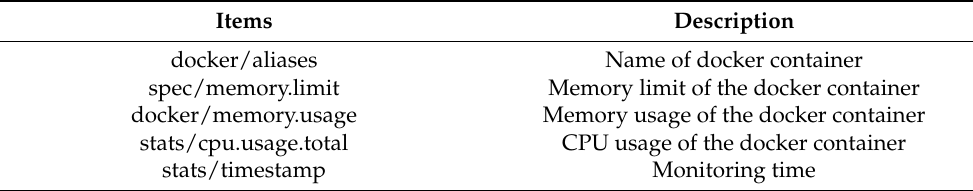
Table 1. Information provided by cAdvisor that can be utilized for monitoring Docker